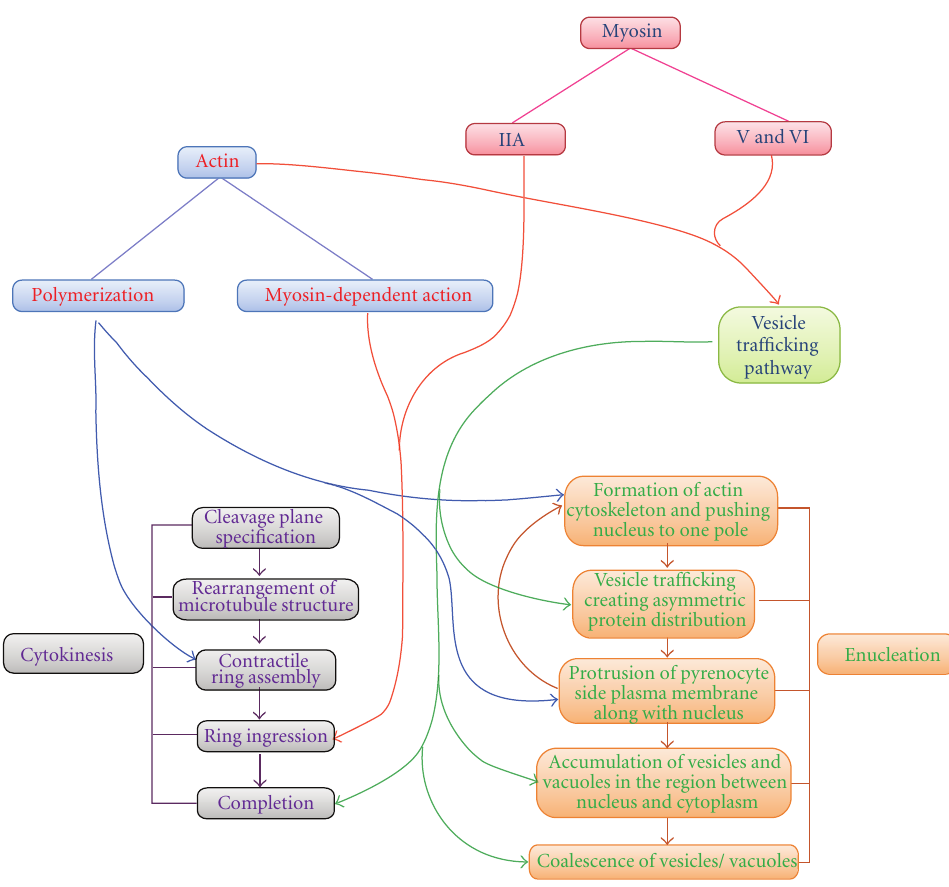
Figure 1: Key events in cytokinesis and enucleation . Even though the final stages of cytokinesis and enucleation are both driven by vesicle tra ffi cking, the preceding events are substantially di ff erent between the two processes.